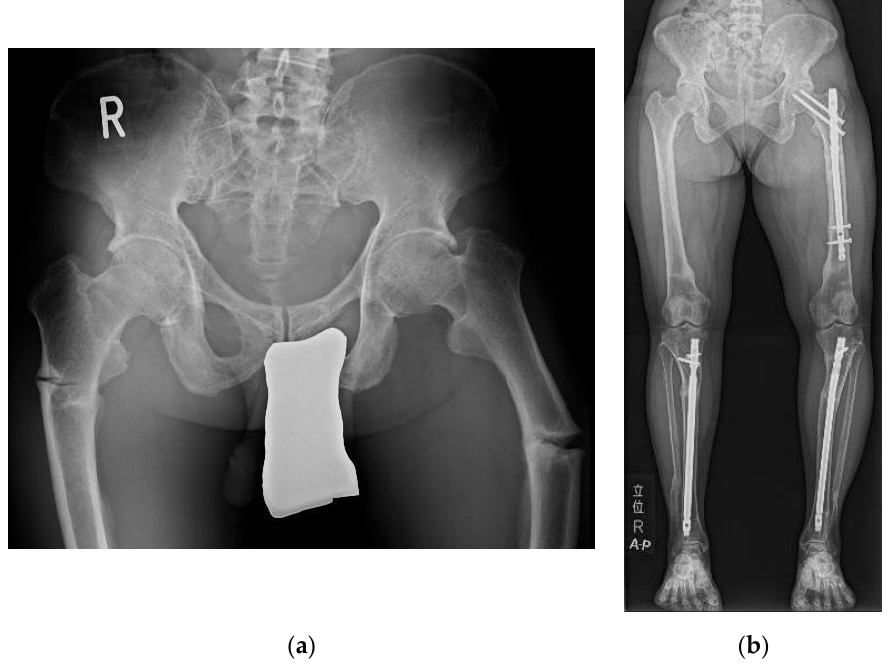
Figure 1. Pseudofracture and fracture in the femurs and tibiae in adult XLH patients. ( a ) Pseudofrac- tures developed spontaneously in both femurs in an adult XLH patient after years of conventional therapy cessation. ( b ) Fractures developed spontaneously in the left femur and both tibiae in an adult XLH patient with conventional therapy.